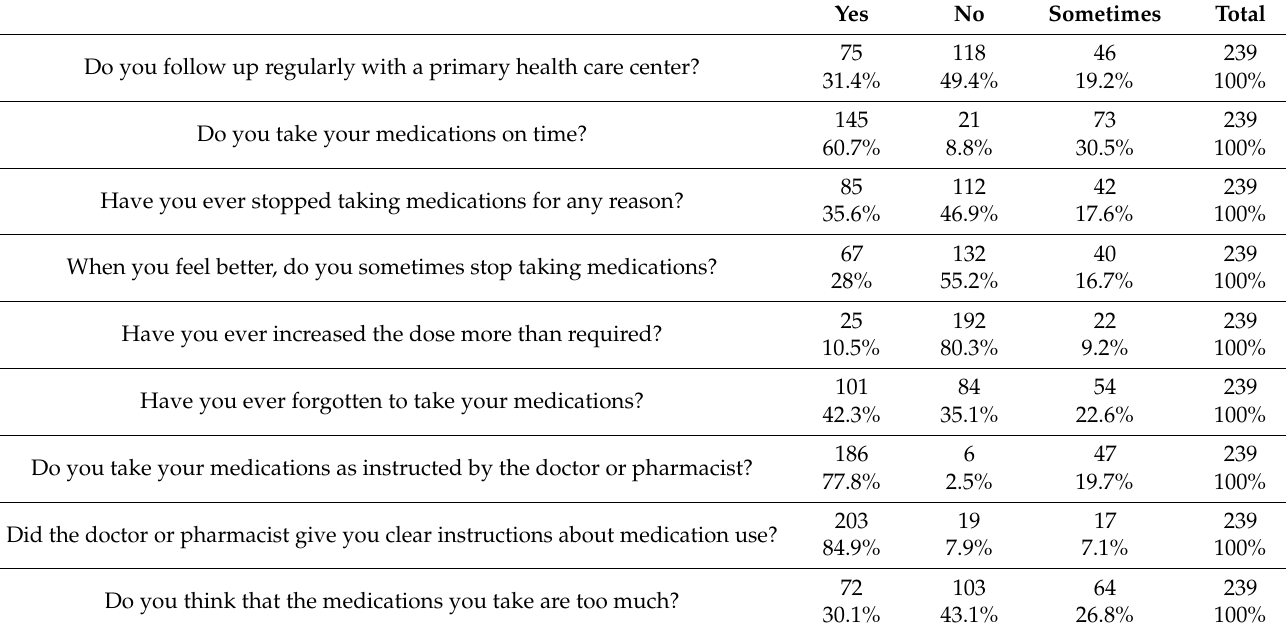
Table 3. Level of medication adherence among the